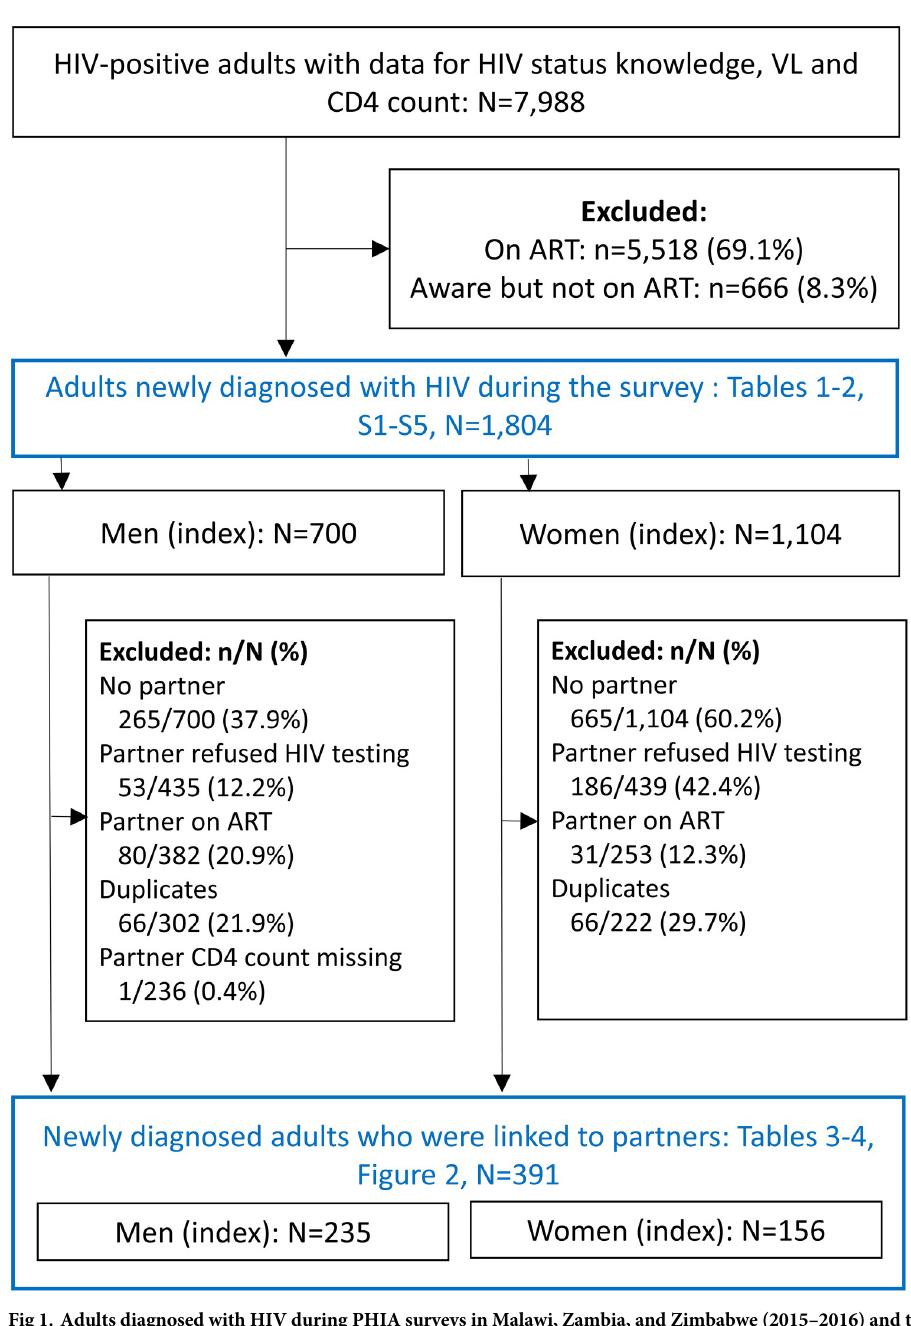
Fig 1. Adults diagnosed with HIV during PHIA surveys in Malawi, Zambia, and Zimbabwe (2015–2016) and their sexual partners included in analysis of late diagnosis of HIV. Flowchart showing unweighted percentages of survey participants excluded from analysis by reason for ineligibility. Abbreviations: PHIA, population-based HIV impact assessment; N, denominator; n, numerator; VL, viral load; ART, antiretroviral therapy. (aOR) and 95% confidence intervals (CI) for factors associated with LD using logistic regres- sion. We used purposeful selection of covariates to build regression models for factors associ- ated with LD [22]. We considered key sociodemographic characteristics, indicators for HIV testing, sexual risk behavior, HIV knowledge, discriminatory attitude toward people living